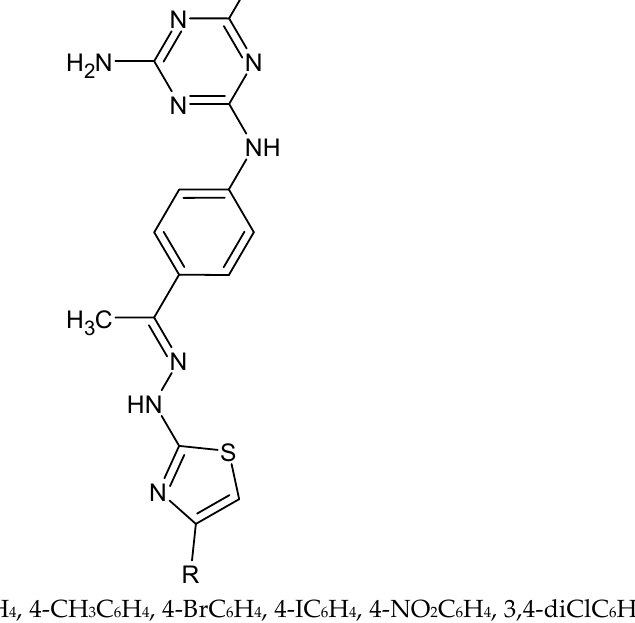
Figure 17. The structure of 2,4-diaminotriazine-thiazole derivatives.